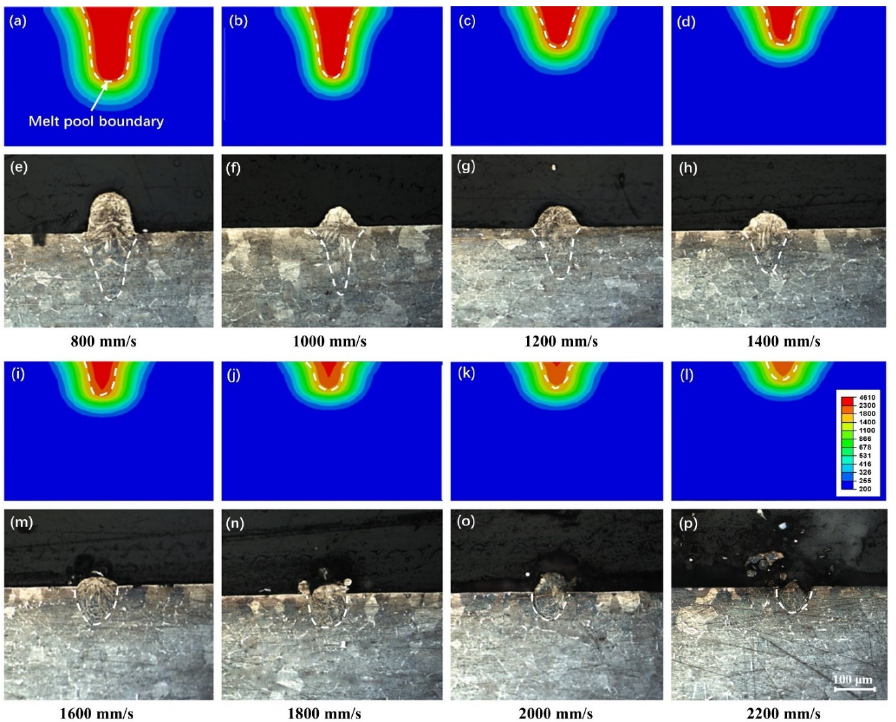
Figure 4. Melt pool morphology of different scanning speeds at a laser power of 400 W: ( a – d , i – l ) simulated; ( e – h , m – p ) experimental.